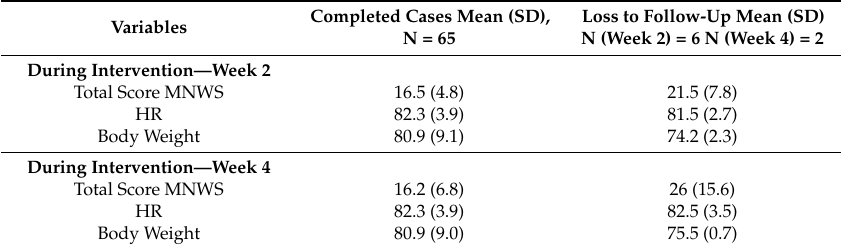
Table 4. Loss to follow-up reflected in the Minnesota nicotine withdrawal scale (MNWS) (N =